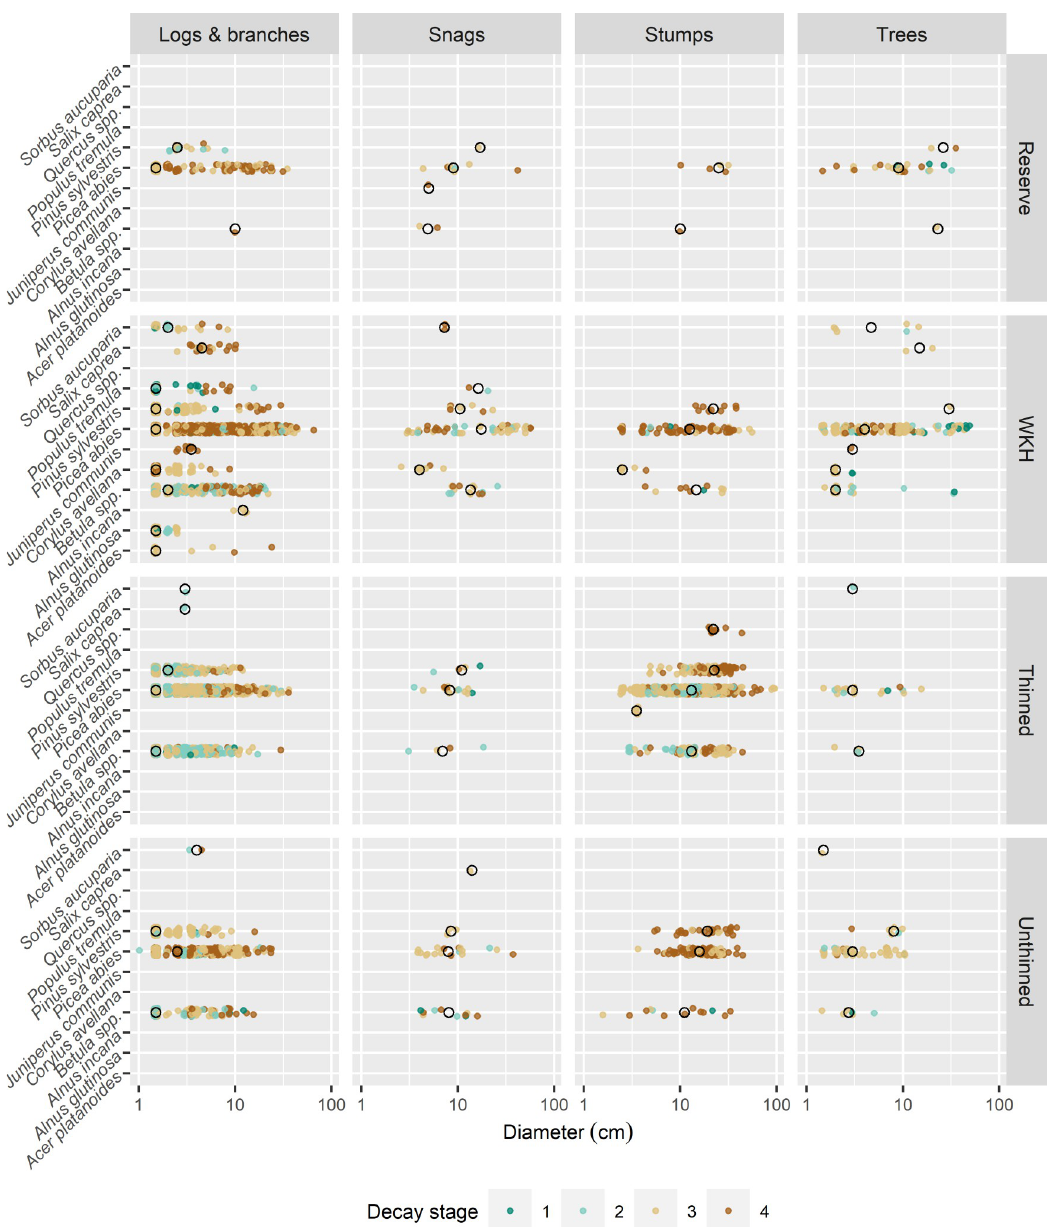
Fig 3. Dead wood measurements. Dead wood objects measured in a 10 m radius around each trap. Black circles represent median values. Decay stage 1 is newly dead wood, 2 and 3 are intermediate decay, and 4 is heavily decayed. Diameter is the average of the diameter at the two ends. Note the logarithmic scale on the x-axis. A slight jitter has been applied to increase readability of overlapping points and draw order has been randomized. Sample sizes are not equal for the four forest types (reserves: 3, Woodland Key Habitats (WKHs): 20, thinned stands: 20, unthinned stands: